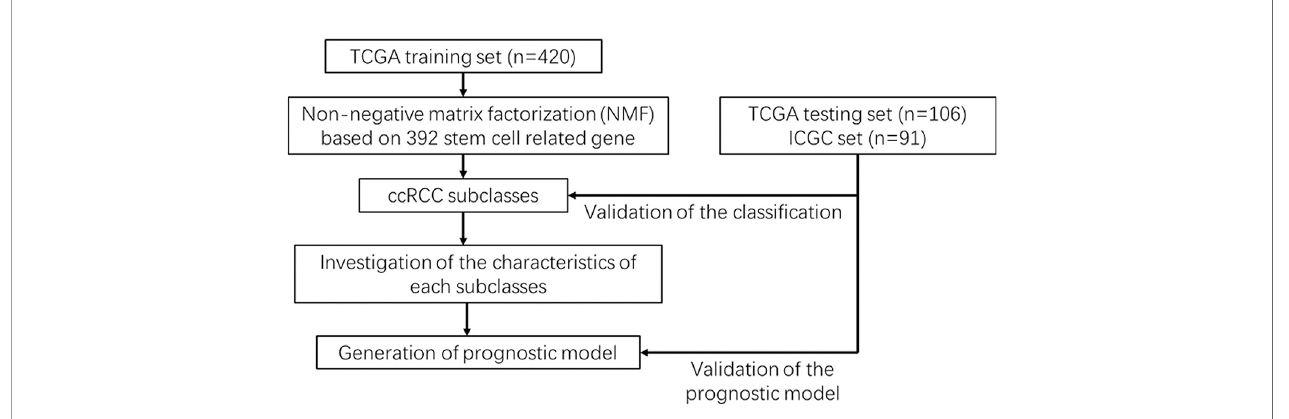
FIGURE 1 | Work fl ow